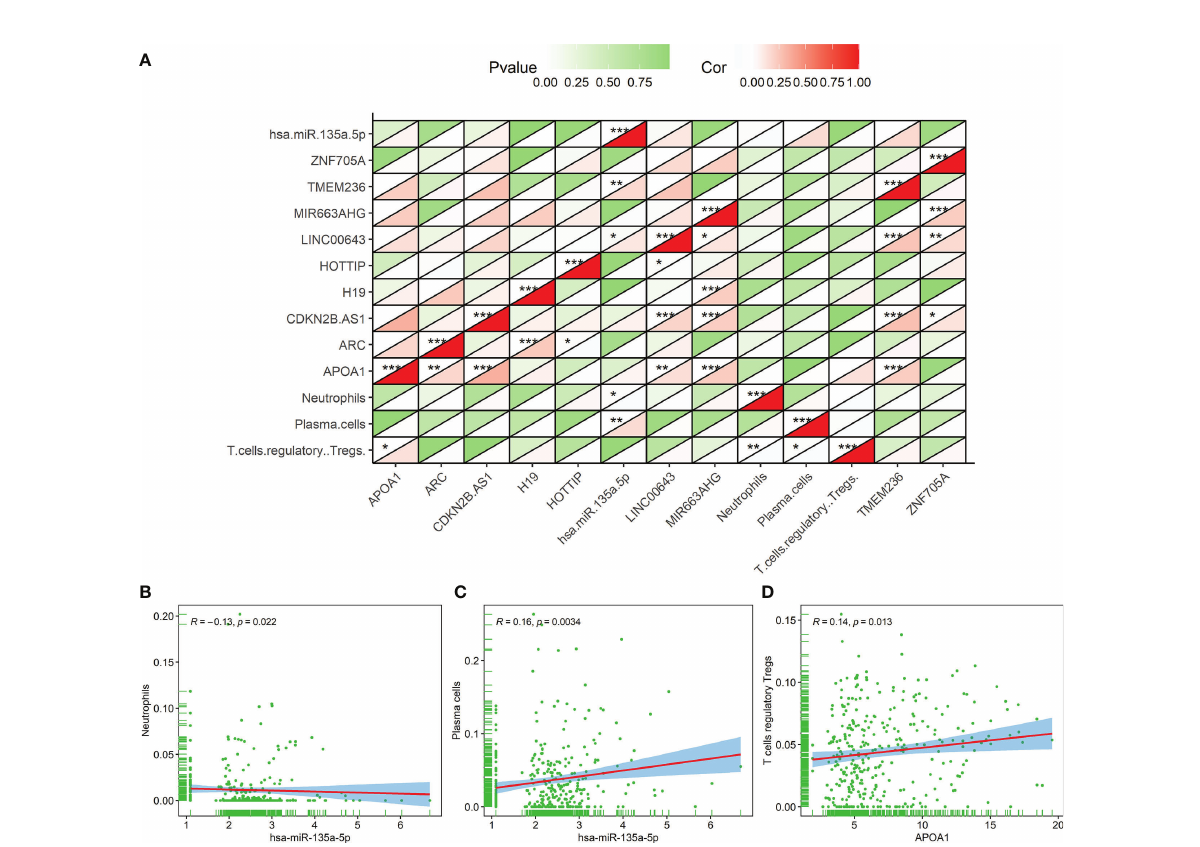
FIGURE 10 The correlation result of the coexpression analysis between tumor-in fi ltrating immune cells and DERNAs related to the prognosis of gastric cancer patients. (A) The coexpression heat map illustrated the coexpression patterns of 10 genes and 3 immune cells. (B – D) Neutrophils and hsa-miR-135a-5p (R = -0.13, p = 0.022), plasma cells and hsa-miR-135a-5p (R = 0.16, p = 0.0034), and regulatory T cells and APOA1 (R = 0.14, p =0.013). *p < 0.05; **p < 0.01; ***p <